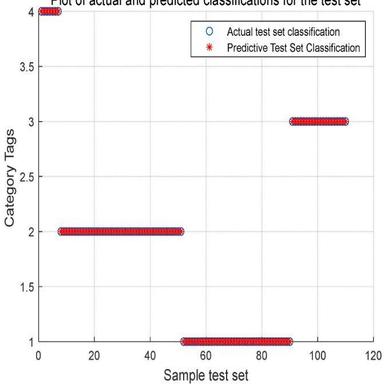
Actual classification diagram and predicted classification diagram of the test data set.